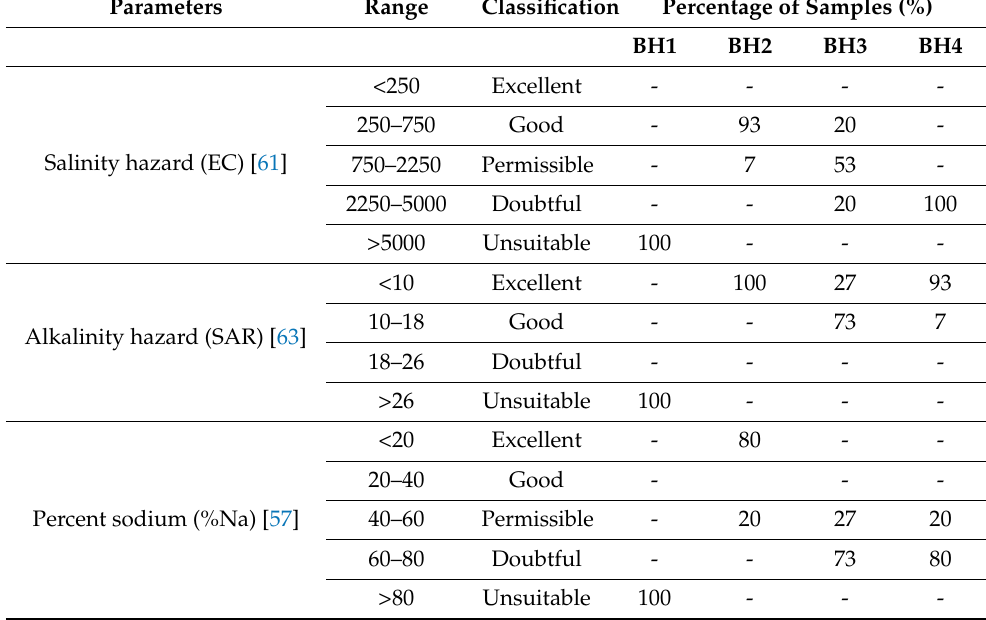
Table 5. Classification of groundwater samples collected from the four monitoring boreholes for irrigation purposes on the basis of EC, SAR and %Na. Parameters